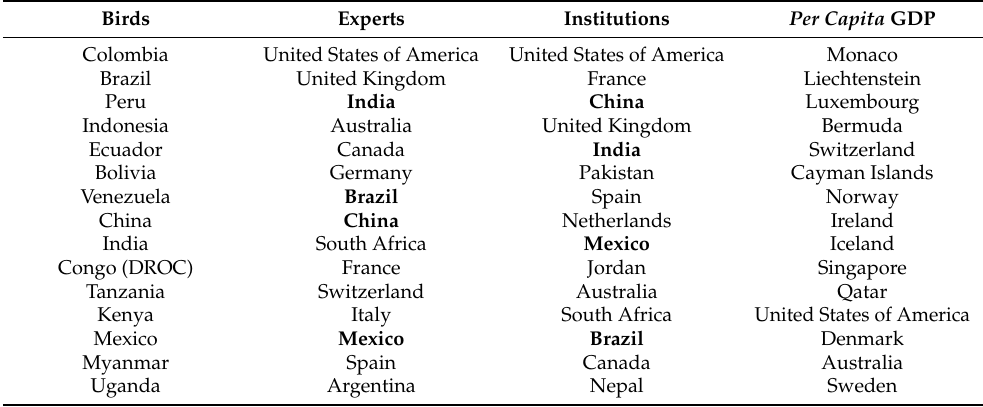
Table 1. Top 15 countries ranked from top to bottom according to the number of birds, experts, insti- tutions and per capita GDP, as explained in Figure 1. In bold are the four countries in the second and third columns also present in the first one. There is no overlap between the first and fourth columns.